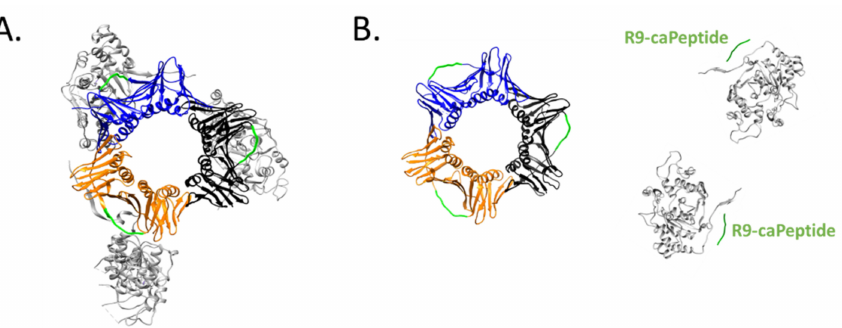
Figure 2. Schematic of targeting PCNA-binding proteins, such as FEN1. ( A ) Structure of the PCNA trimer (orange, blue, and black subunits) complexed to FEN1 (gray) [PDB ID: 1UL1 [97]]. The caPep- tide region of PCNA (amino acids 126–133) is shown in green [PDB ID: 6FCM [108]]. ( B ) R9-caPeptide (labeled in dark green) binds to FEN1 to disrupt interactions with PCNA. The binding site of caPeptide-FEN1 shown in solution is theoretical. Images were made in the software Chimera [109]. Growth inhibition experiments showed that R9-caPeptide was cytotoxic in a dose- dependent manner to cancer cell lines derived from breast, lymphoma, neuroblastoma, and pancreas [88,104,105,107]. Treating malignant cancer cells with R9-caPeptide also caused stalled DNA replication forks, DNA damage, cell cycle arrest, and